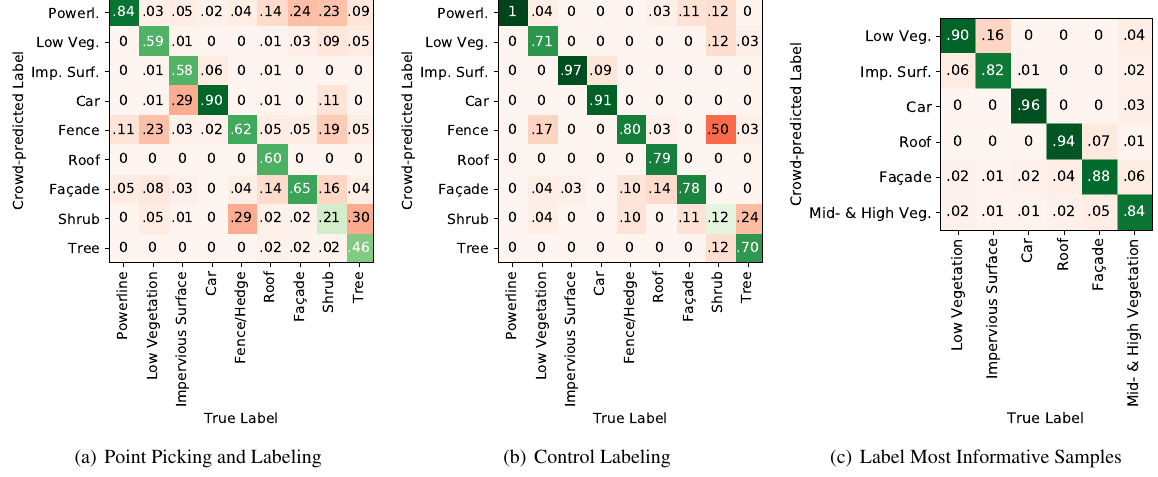
Figure 3. Normalized confusion matrices for all three types of conducted crowd jobs.